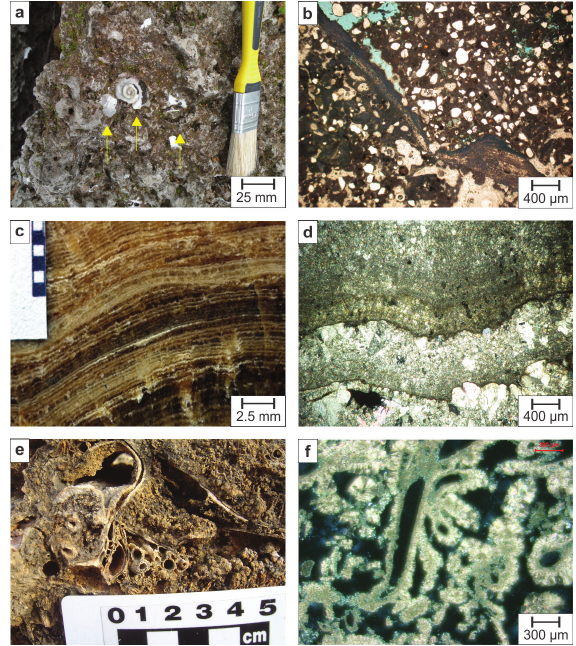
Figure 4 - Plate showing photographs and microscopic photographs (optical microscope) of upper facies. a : Photograph of quartz wackestone with gastropods fossils (arrows) (Pantanal do Miranda). b : Microscopic photograph of quartz wackestone with fossils (calcrete) with preserved root cavity (Pantanal do Miranda). c : Photograph of laminated boundstone (tufa, with well-marked stromatolitic lamination (Serra da Bodoquena). d : Microscopic photograph (polarized) of laminated boundstone (tufa) showing cementation and recrystallization (Serra da Bodoquena). e : Photograph of massive boundstone (tufa) showing macrophytes fossils (Serra da Bodoquena). f : Microscopic photograph (polarized) of massive boundstone (tufa) with biological porosity (macrophytes and microphytes) (Serra da Bodoquena).